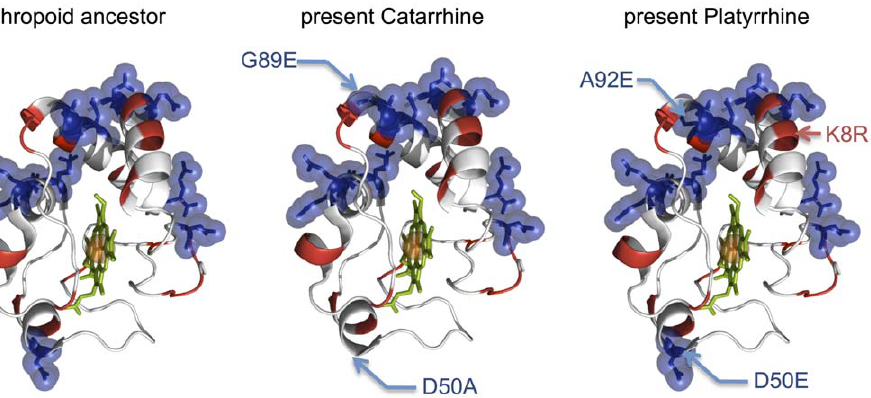
Figure 4. Electrostatic evolution of primate cytochrome c . The replacement of charged amino acids on the anthropoid lineage has been shown on the structure of cyt c ( Bos taurus , Pdb: 1HRC). Negatively charged amino acids (D and E) are represented by a blue sphere and positively charged amino acids (K,R,H) are red.